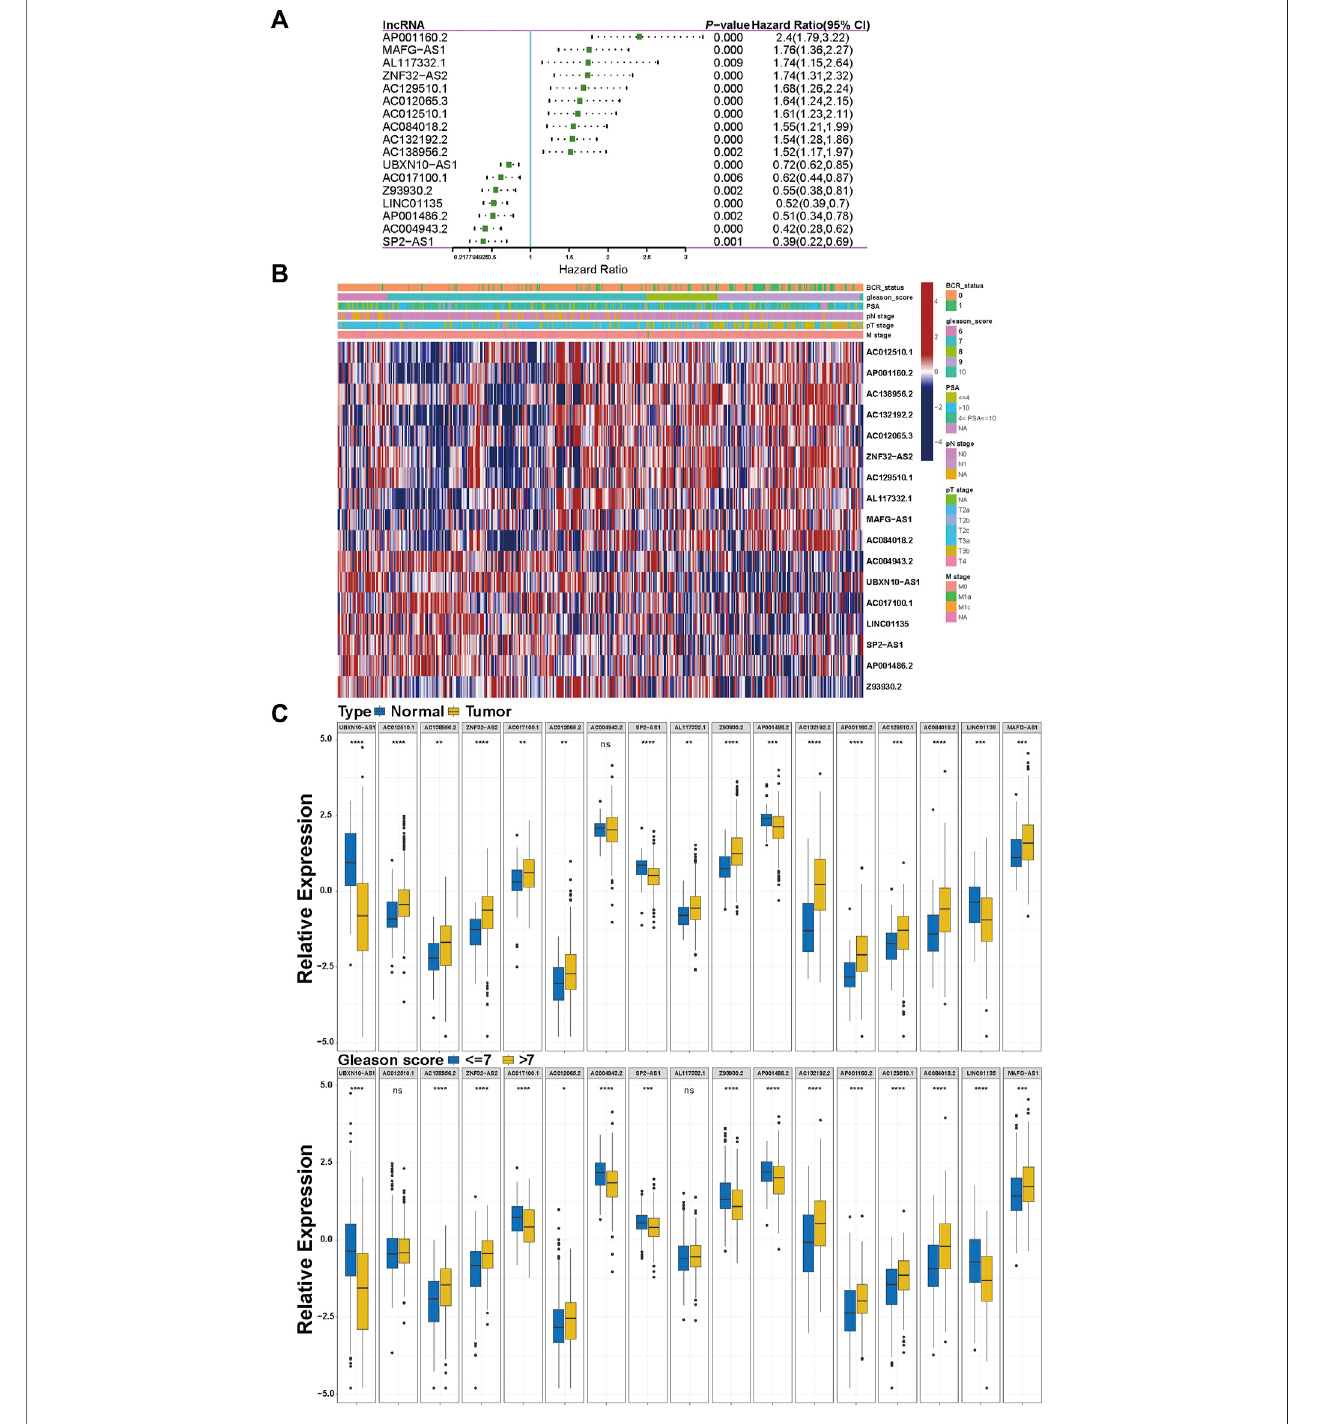
FIGURE 2 | Clinical characteristics of the 17 prognostic m5C-related lncRNAs. (A) The result of univariate Cox regression for the 17 prognostic m5C-related lncRNAs. (B) The heatmap of clinical signature of the 17 prognostic m5C-related lncRNAs. (C) The correlations between the 17 prognostic m5C-related lncRNAs and clinical features. * p < 0.05, ** p < 0.01, *** p < 0.001, **** p < 0.0001.